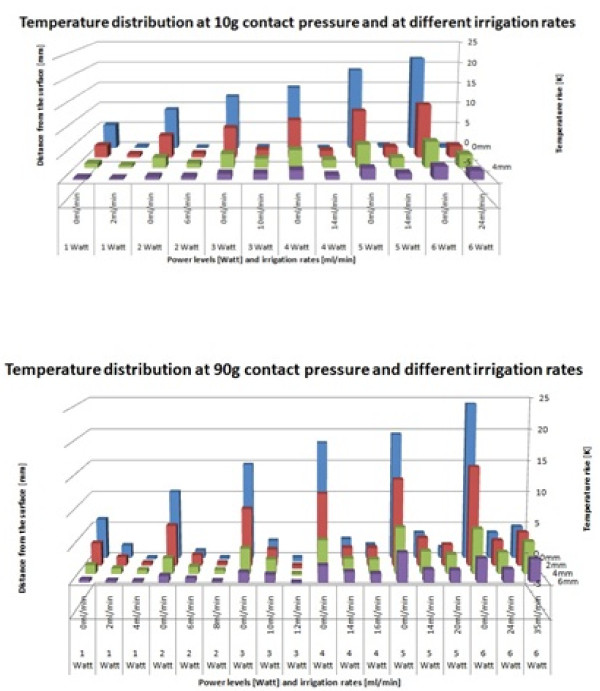
Temperature distribution at different distances from the catheter tip: 0 mm, 2 mm, 4 mm, and 6 mm from the catheter tip and the interface surface. Higher contact pressures require higher irrigation rates to achieve similar cooling effects. Each test started at the baseline temperature, e.g. the prior tests did not influence the following test results.